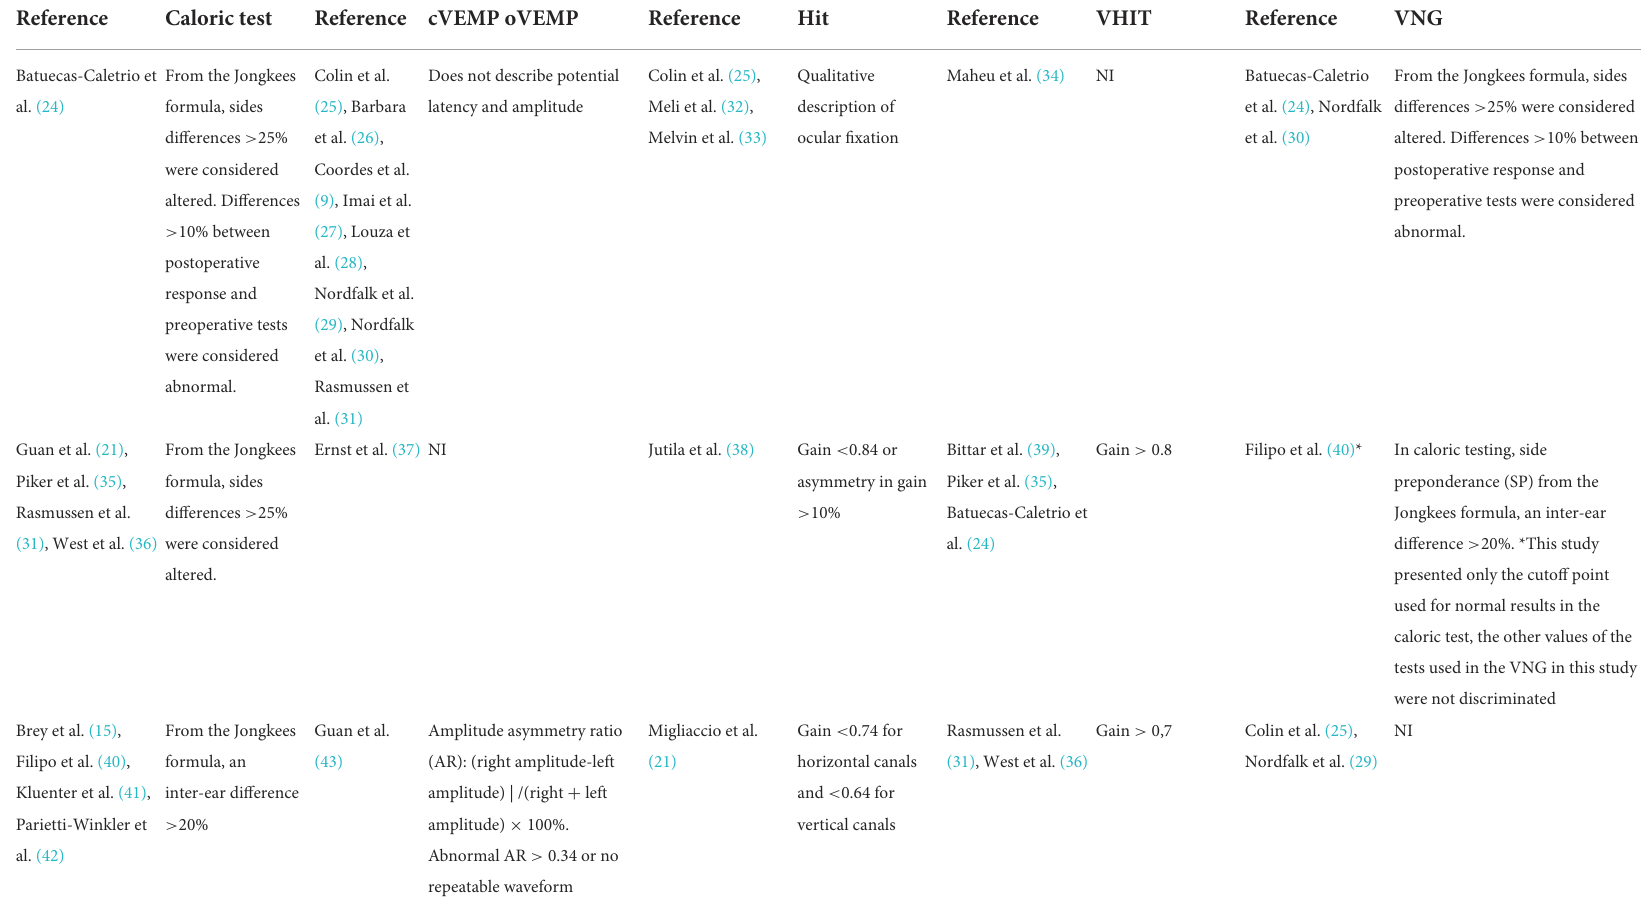
TABLE 1 Cut-off points used to discriminate reference values for tests considered